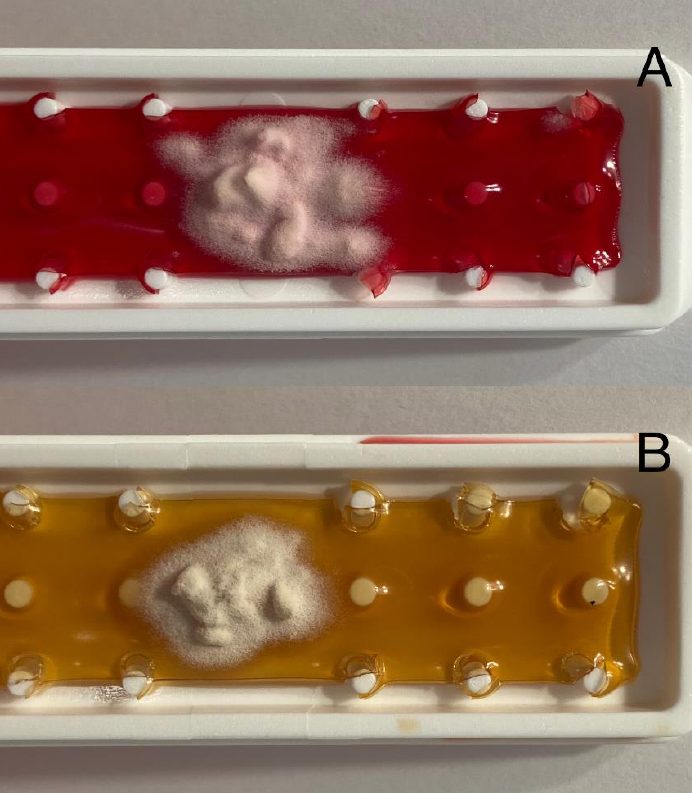
Figure 3. Pictures of Trichophyton tonsurans culture: ( A ) Fungiset agar growth medium with actidione (cycloheximide) and phenol red; ( B ) Sabouraud dextrose agar growth medium with chloramphenicol. Courtesy of Prof. J. C. Szepietowski.